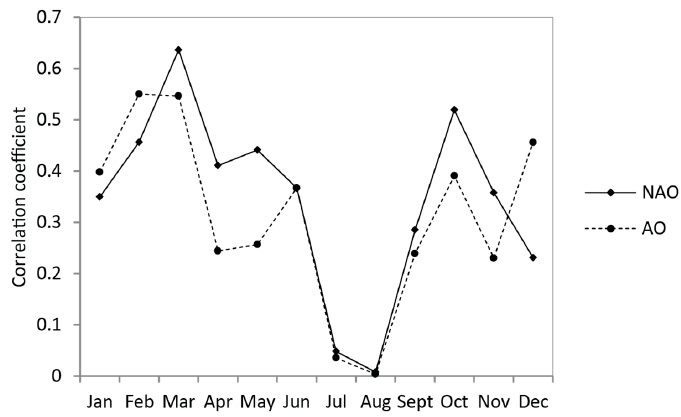
Figure 4. Monthly variation of the correlation between the monthly average temperature anomalies and the monthly North Atlantic Oscillation (NAO) and Arctic Oscillation (AO) indices for the period